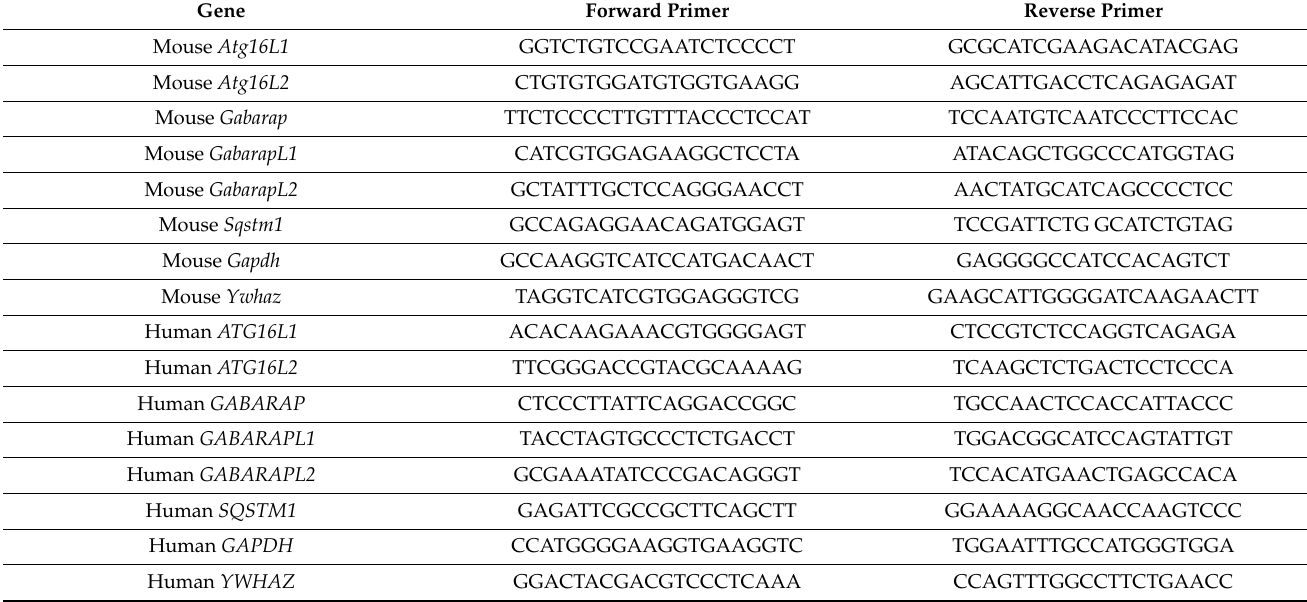
Table 1. Primers